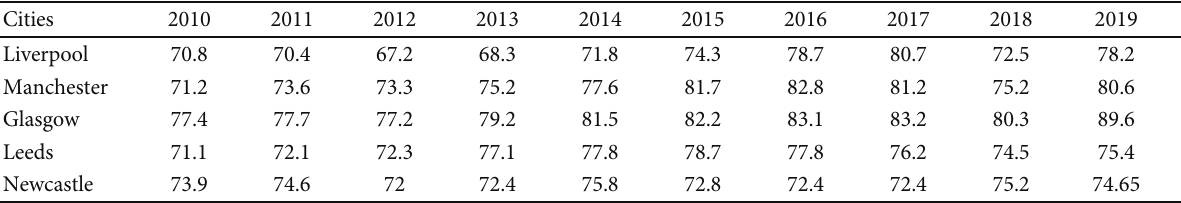
Table 1: Accommodation utilization.